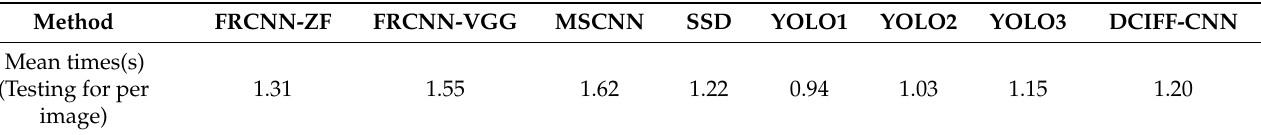
Table 3. The computational complexity analysis for different methods in terms of NWPU VHR-10